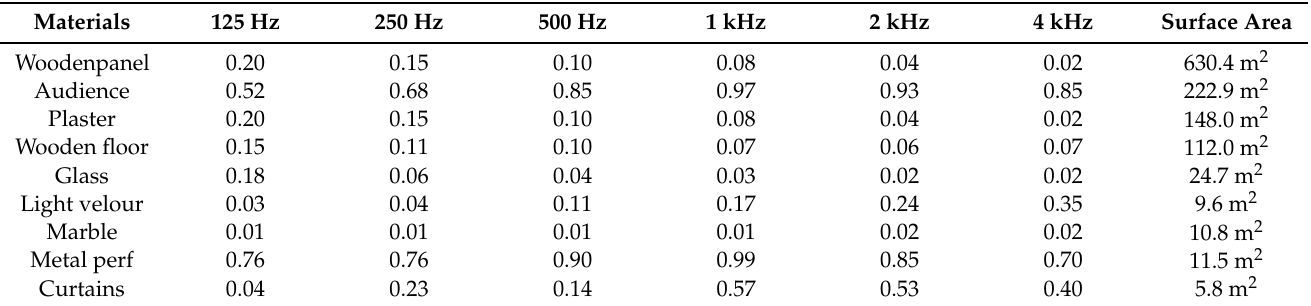
Table 1. The chosen materials with their absorption coefficient across the frequency bands, and the overall surface area of each of them, as used in the early versions of the